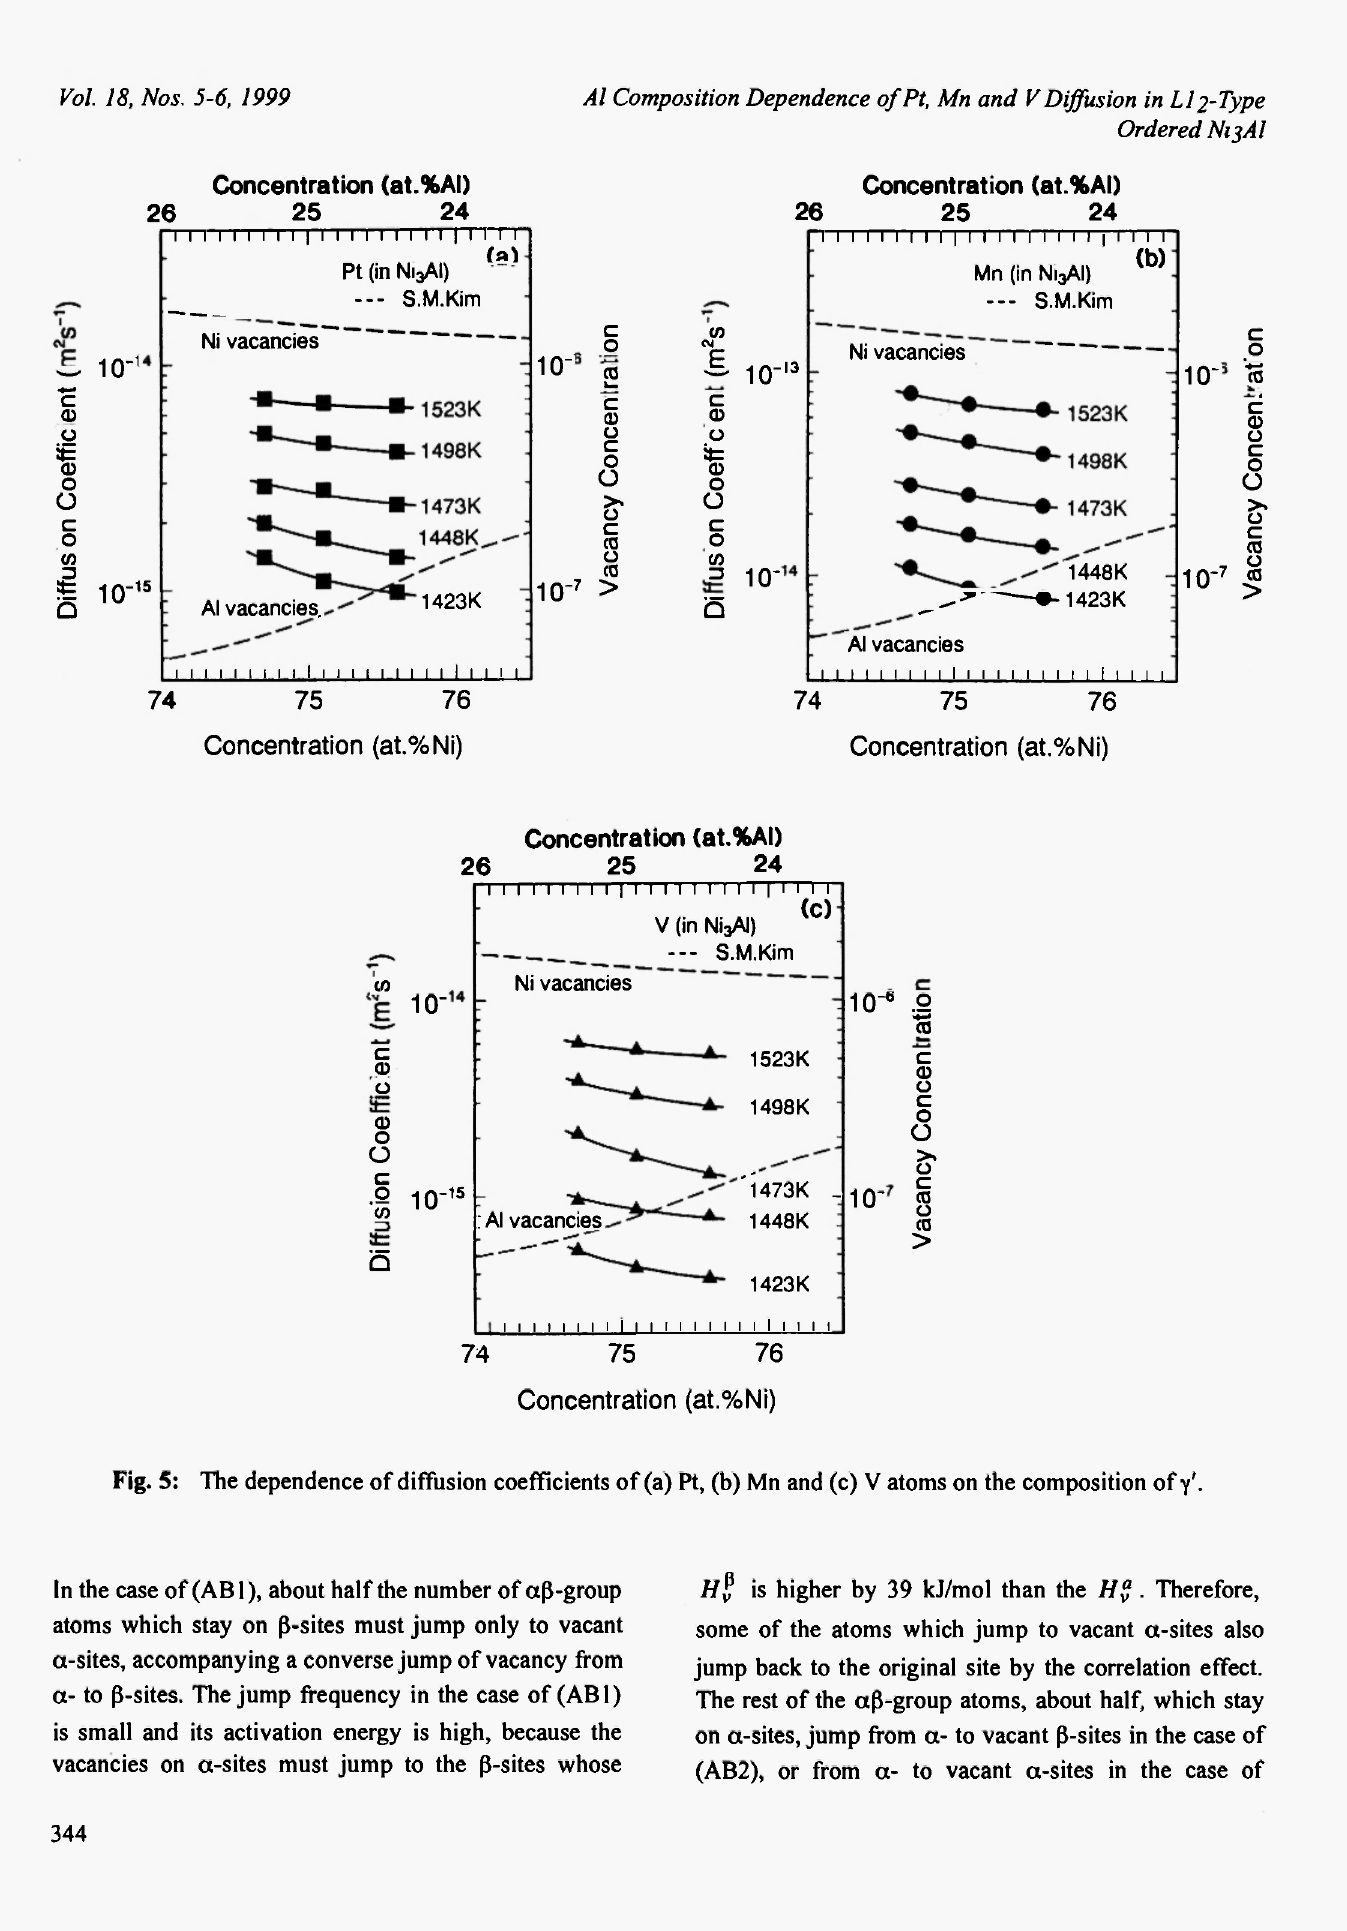
ΗI is higher by 39 kJ/mol than the Η ζ . Therefore, some of the atoms which jump to vacant α-sites also jump back to the original site by the correlation effect. The rest of the αβ-group atoms, about half, which stay on α-sites, jump from a- to vacant ß-sites in the case of (AB2), or from a- to vacant α-sites in the case